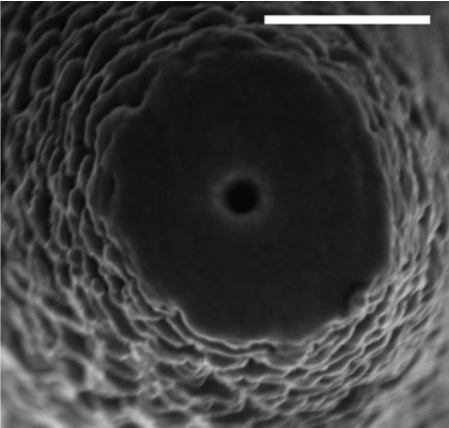
Figure 4 Cutoff tip of an aluminum-coated fi ber with a gold- coated end face and FIB-cut aperture (scale bar = 500 nm). Reprinted